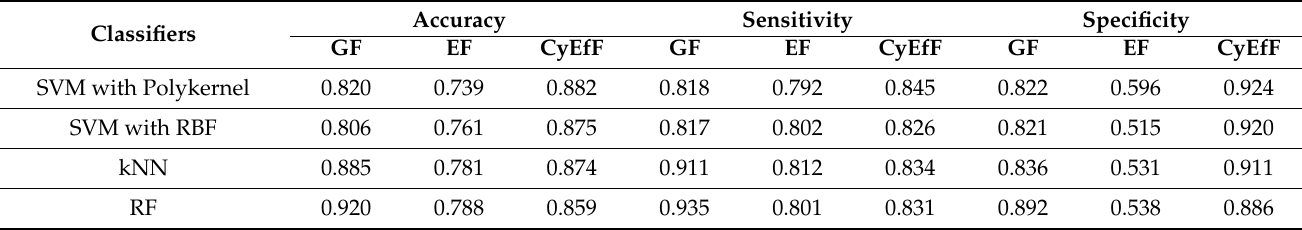
Figure 3. ( a ): Original CE-NBI image, ( b ): Pre-processed image with one random trajectory, ( c ): The stage profile of the random trajectory plus the cyclist’s energy and power values of the random trajectory and the 500 trajectories (whole image). Table 1. Classification results of four classifiers using three features sets.